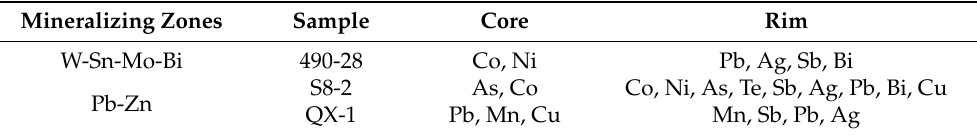
Figure 16. Mapping of pyrite from Sample QX-1. Table 6. The core-rim texture of pyrites.